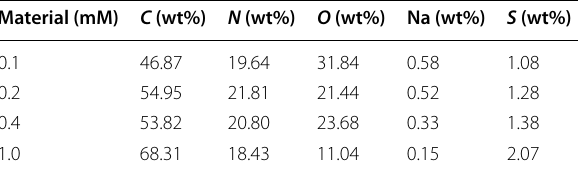
Table 1 Elemental composition for the polymerized electrodes with different MB concentrations